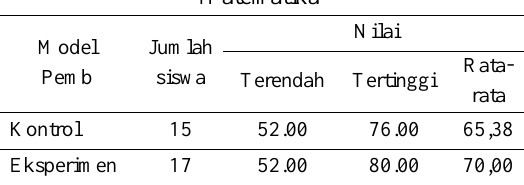
Tabel 2. Rangkuman Rata-Rata Prestasi